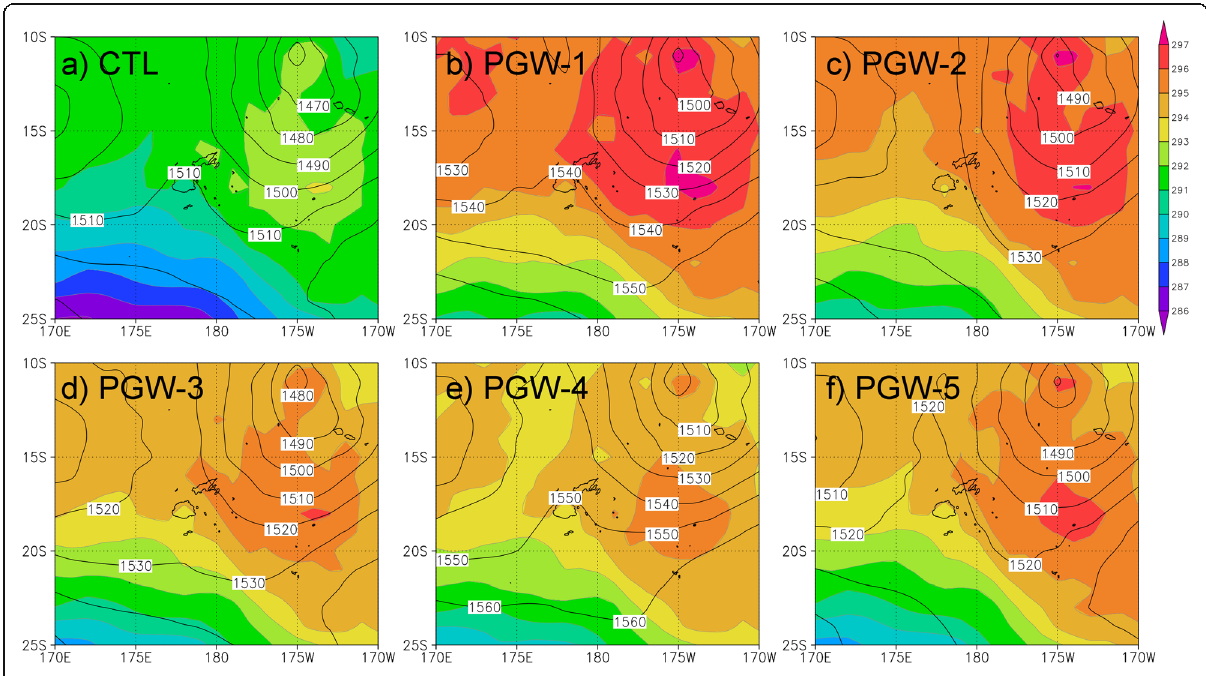
Fig. 3 Spatial distribution of atmospheric temperature and geopotential height at 850 hPa for the initial time. a The result of CTL. b - f The results of each PGW simulation. Shading is atmospheric temperature, and contours are geopotential height. The unit of the color bar is Kelvin